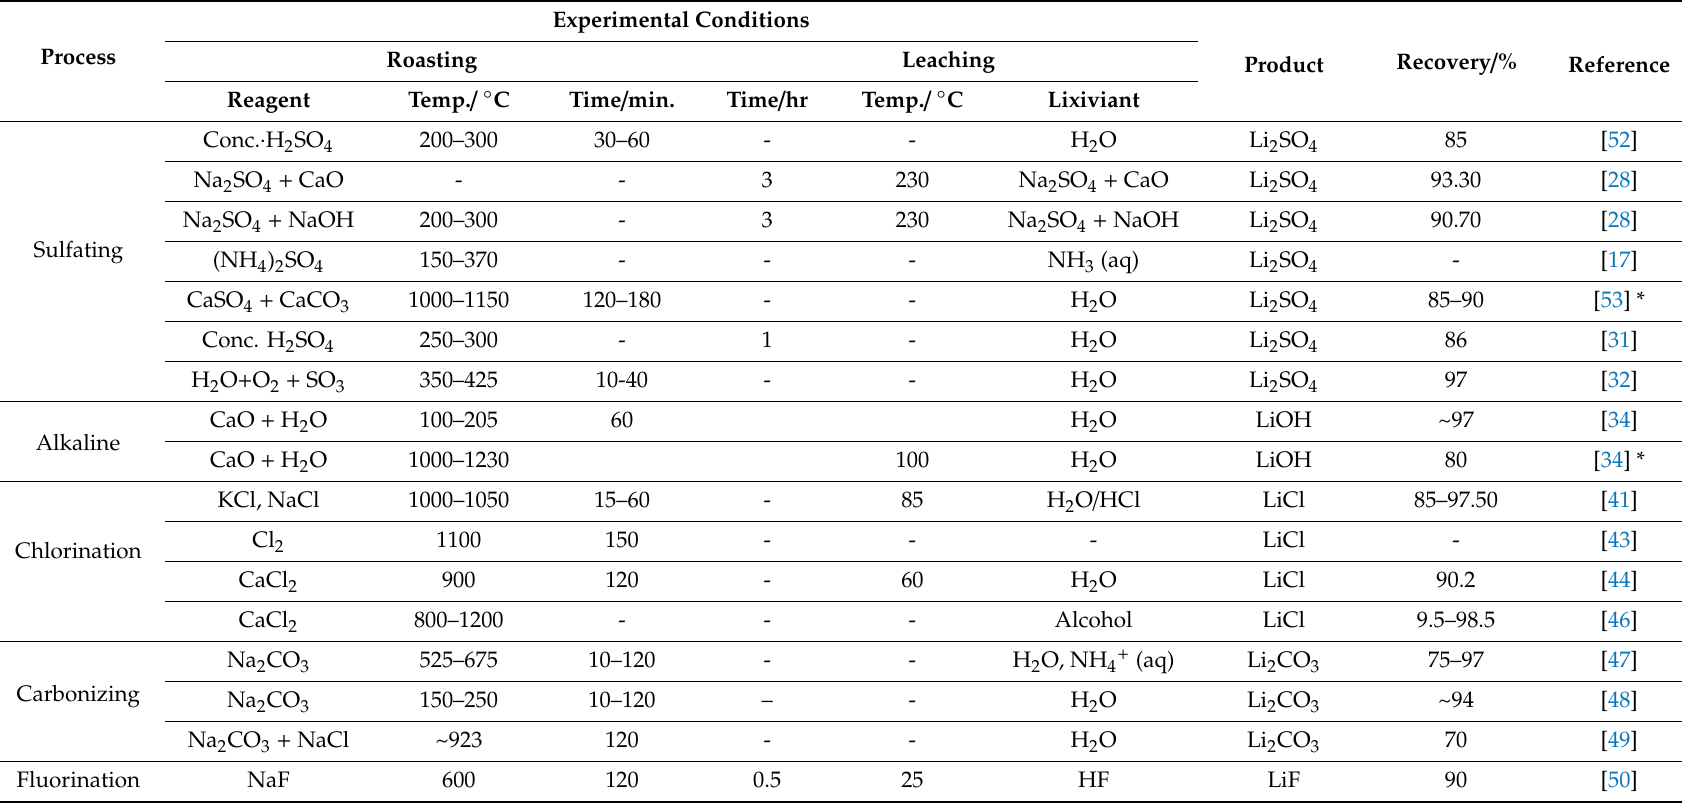
Table 2. Summary of literature for the recovery of lithium from spodumene using the major beneficiation